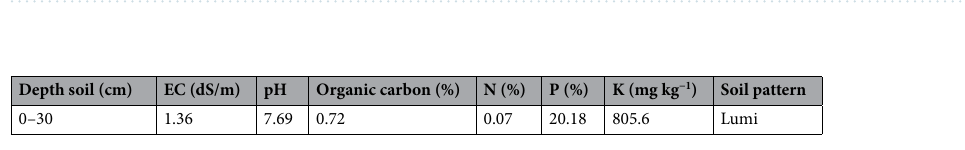
Table 7. The physicochemical properties of the field soil used in this experiment.